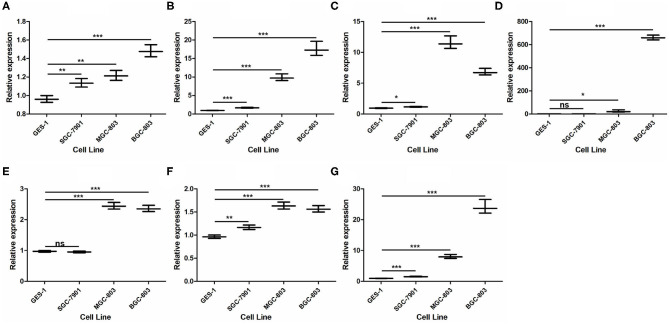
Further verification of the overexpression of seven GRGs in RT-qPCR analysis. (A) STC1; (B) CLDN9; (C) EFNA3; (D) ZBTB7A; (E) NT5E; (F) NUP50; (G) CXCR4. Compared to normal tissues, ns, not significant, *P < 0.05, **P < 0.01, ***P < 0.001.